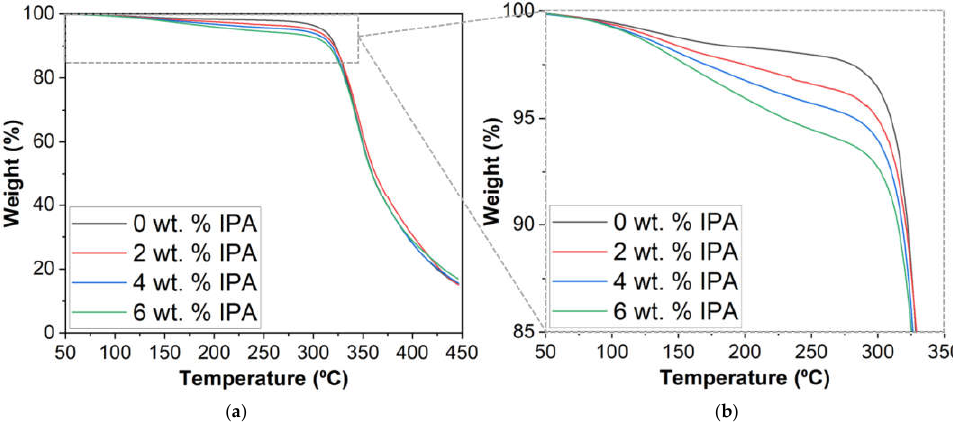
Figure 2. TGA of adhesive samples containing 0, 2, 4, and 6 wt.% of IPA ( a ) from 0 to 450 ⁰C; ( b ) from 50 to 350 °C located inside the dashed rectangle of Figure 2a.